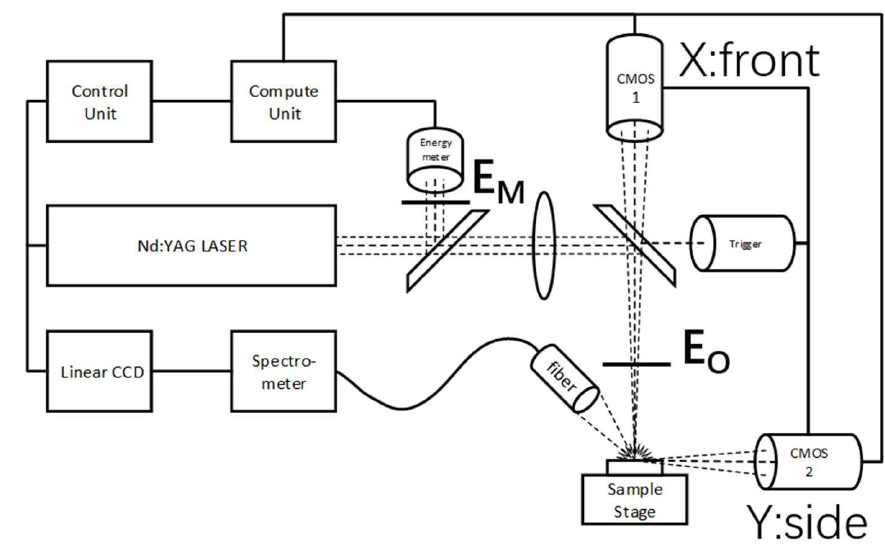
Figure 1. LIBS system schematic for key parameter monitoring.